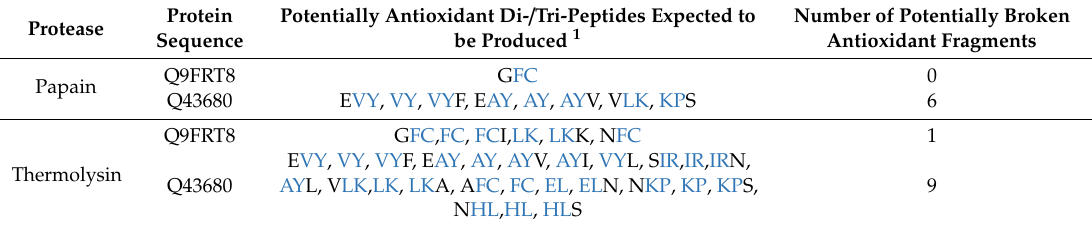
Table 2. Possible Small Antioxidant Peptides Produced from the Theoretical Hydrolysis of Mung Bean Albumin Sequences by Papain and Thermolysin.